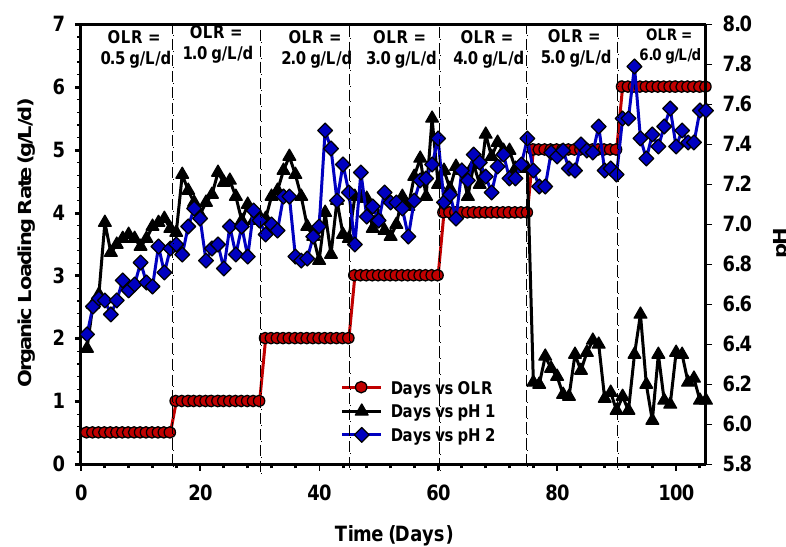
Figure 10. pH profile of UASB 1 and 2 reactors.